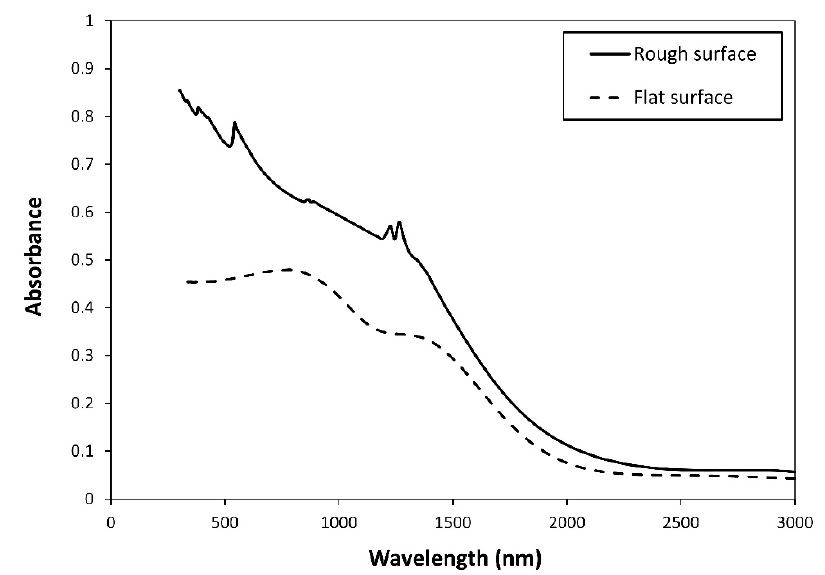
Figure 4. Comparing absorbance of flat and rough (l x = 100 nm, l y = 100 nm, and h = 50 nm) Tungsten finite thickness film by the FDTD solution.